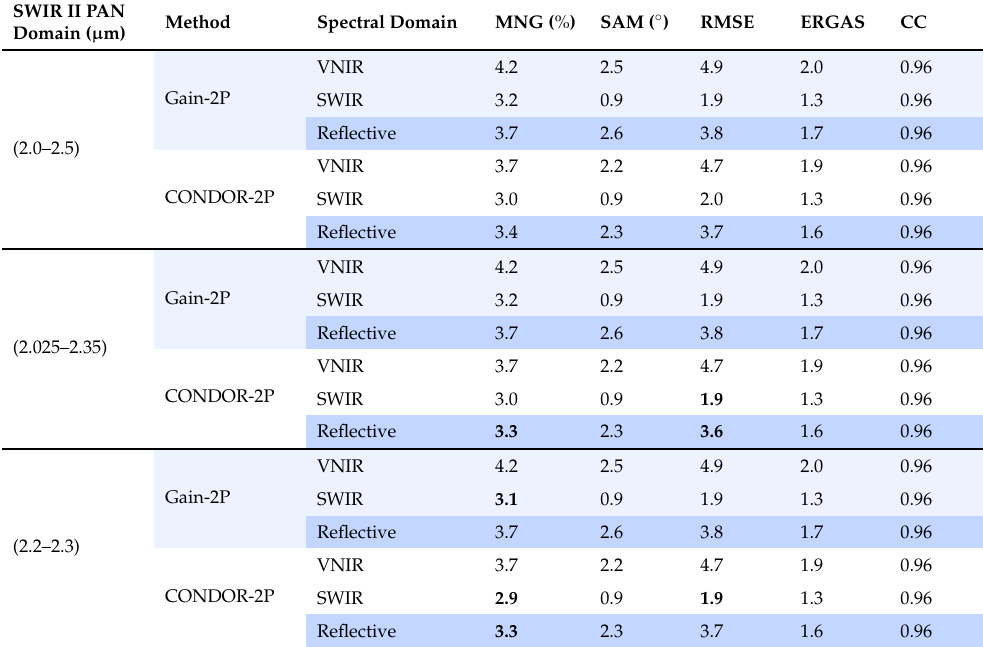
Table 1. “Stadium”: quality criteria calculated on the whole images, for the three proposed SWIR II PAN spectral bands. The optimal values (according to the SWIR II PAN domain only) are identified in